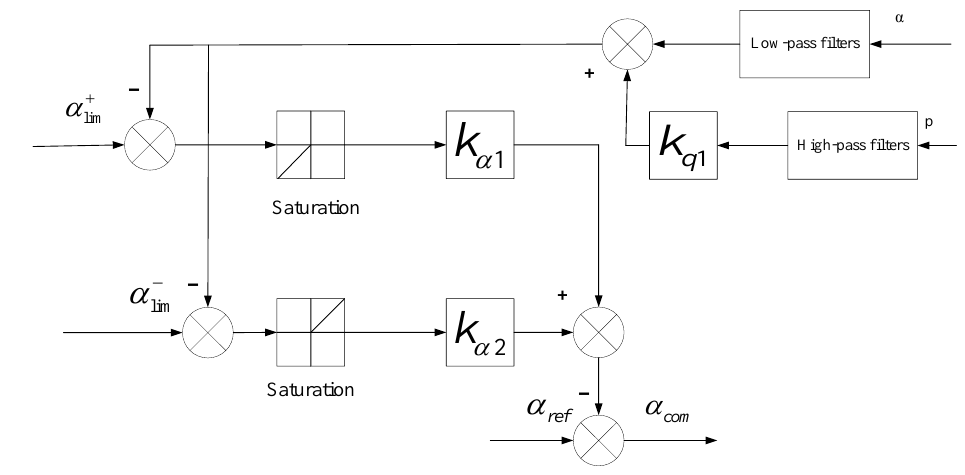
Figure 8. Attack angle envelope restriction module framework.